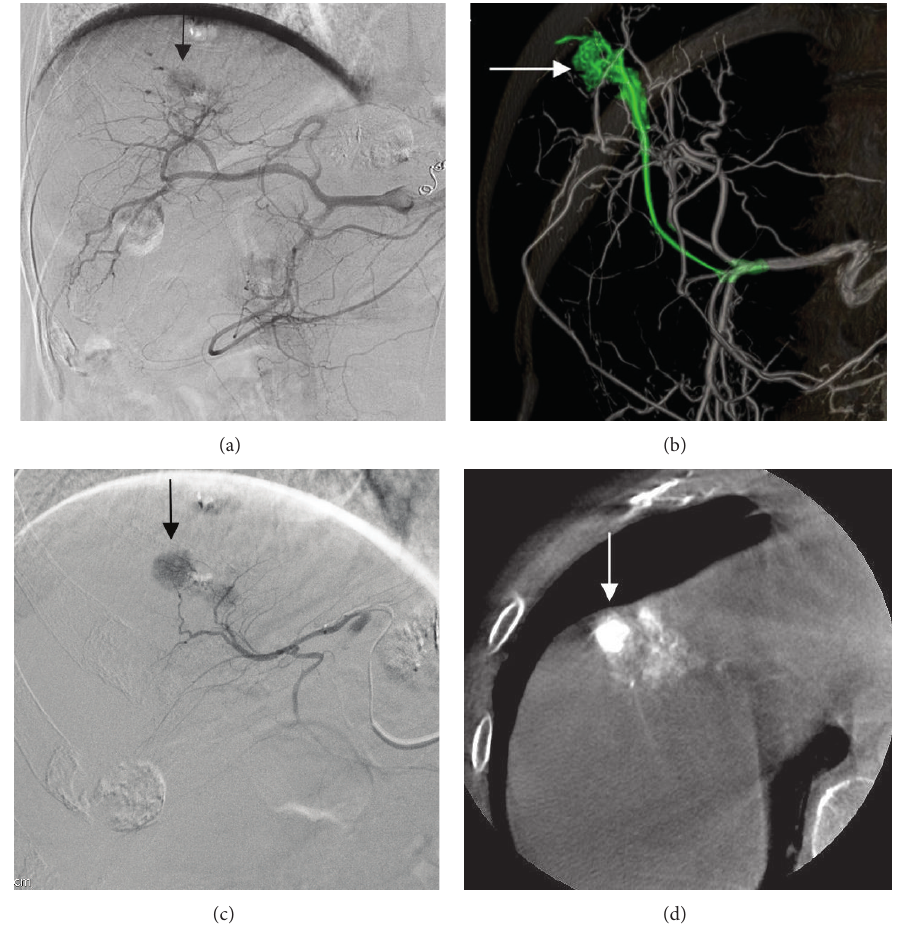
Figure 1: Images from a patient with hepatocellular carcinoma undergoing transarterial chemoembolization with the assistance of automated feeder-vessel detection software. (a) The common hepatic artery angiogram shows the target tumor (arrow) at the right hepatic dome. Identifying the complex arterial vasculature of the tumor feeder is difficult. (b) The volume-rendered C-arm computed tomography (CT) image, showing the extracted tumor feeder by the software as a path from the catheter to the target (arrow) indicated in green. (c) Selective catheterization directly into the suggested feeder artery, based on the software analysis, shows tumor enhancement (arrow). (d) The axial C-arm CT image, obtained during contrast injection from the same feeder artery, confirms target enhancement (arrow) in association with the treatment